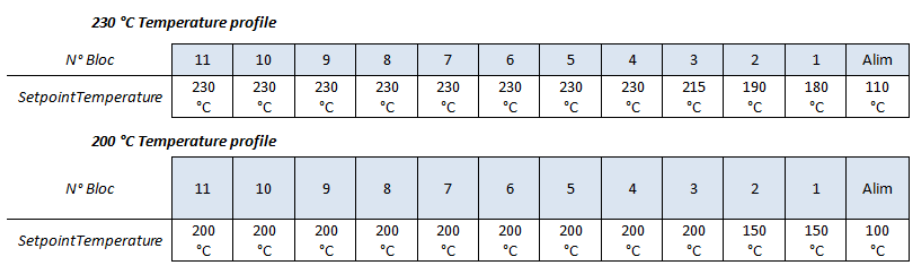
Figure 2. Diagram of the temperature profile in the